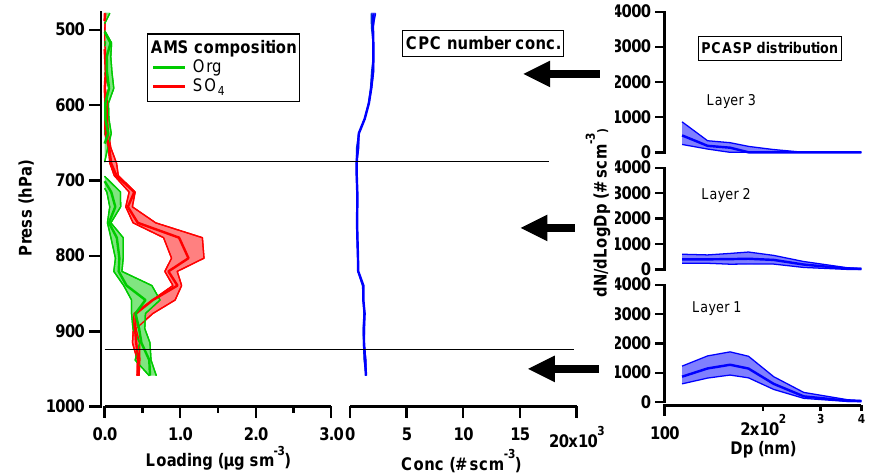
Fig. 10. Average altitude profile (median and interquartile ranges) during the morning of the MCS-dominated regime over East Sabah of organic and sulphate aerosol loading, number concentration and number/size distributions for each layer. One profile on 16 July 2008, 10:30 LT.